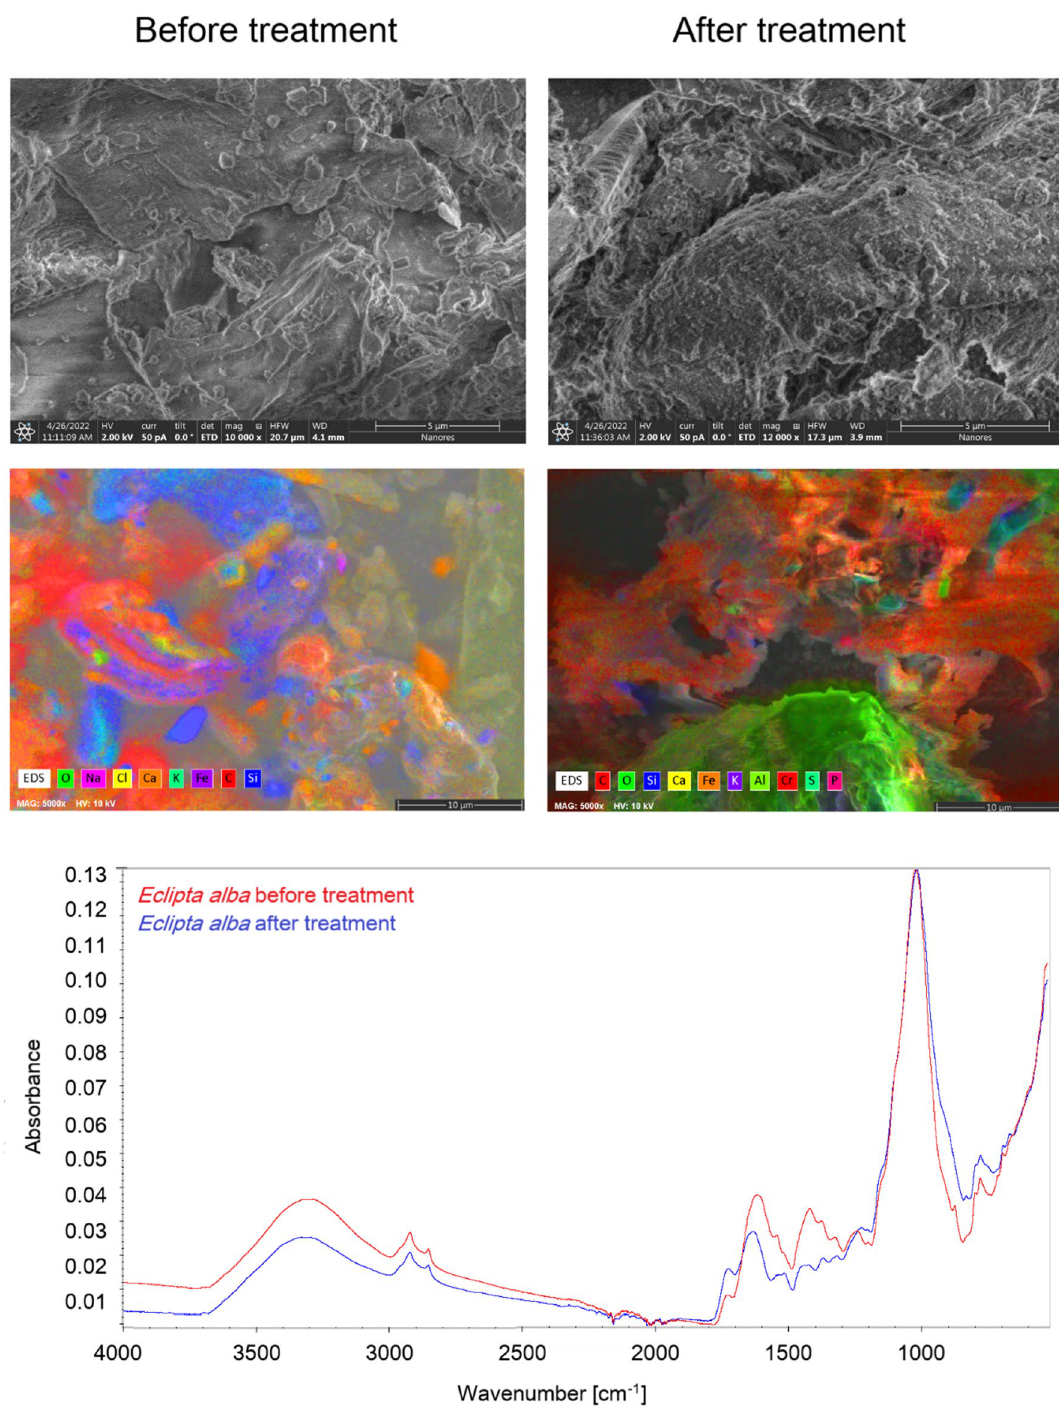
Figure 4. FT-IR spectra and SEM with EDS images of Eclipta alba powder before and after